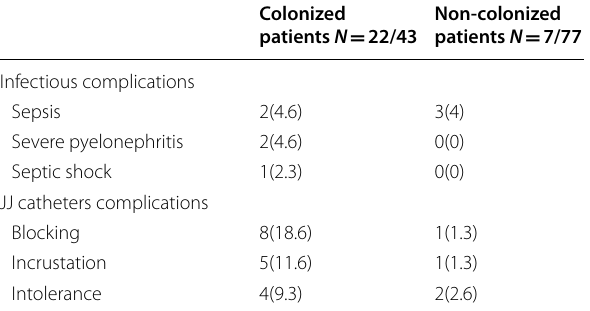
Table 5 Comparison of various infectious and stent- related complications between colonized and non- colonized